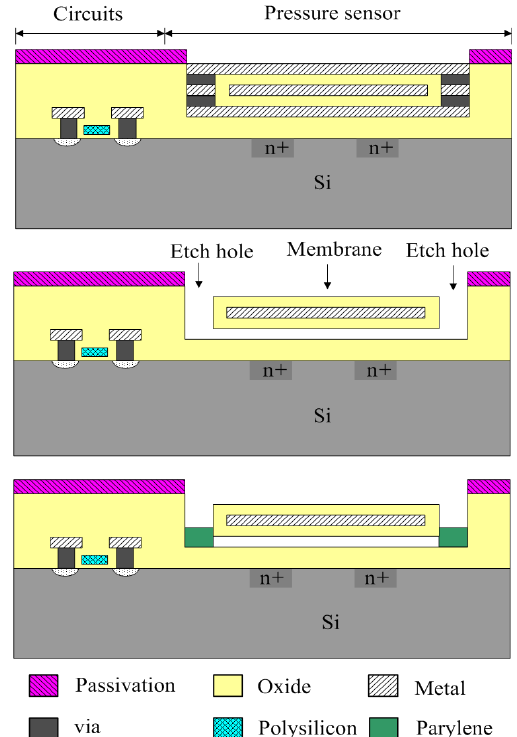
Figure 11. Process flow of the FET pressure sensor: (a) after completion of CMOS process, (b) etching the sacrificial layers, and (c) sealing the etch